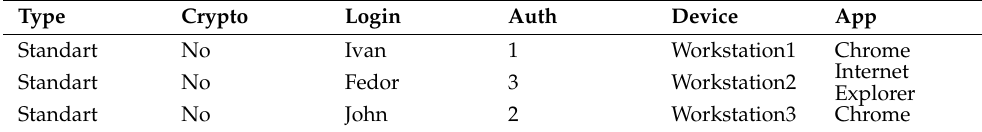
Table 14. Example of query results of the algorithm for Feature 9.